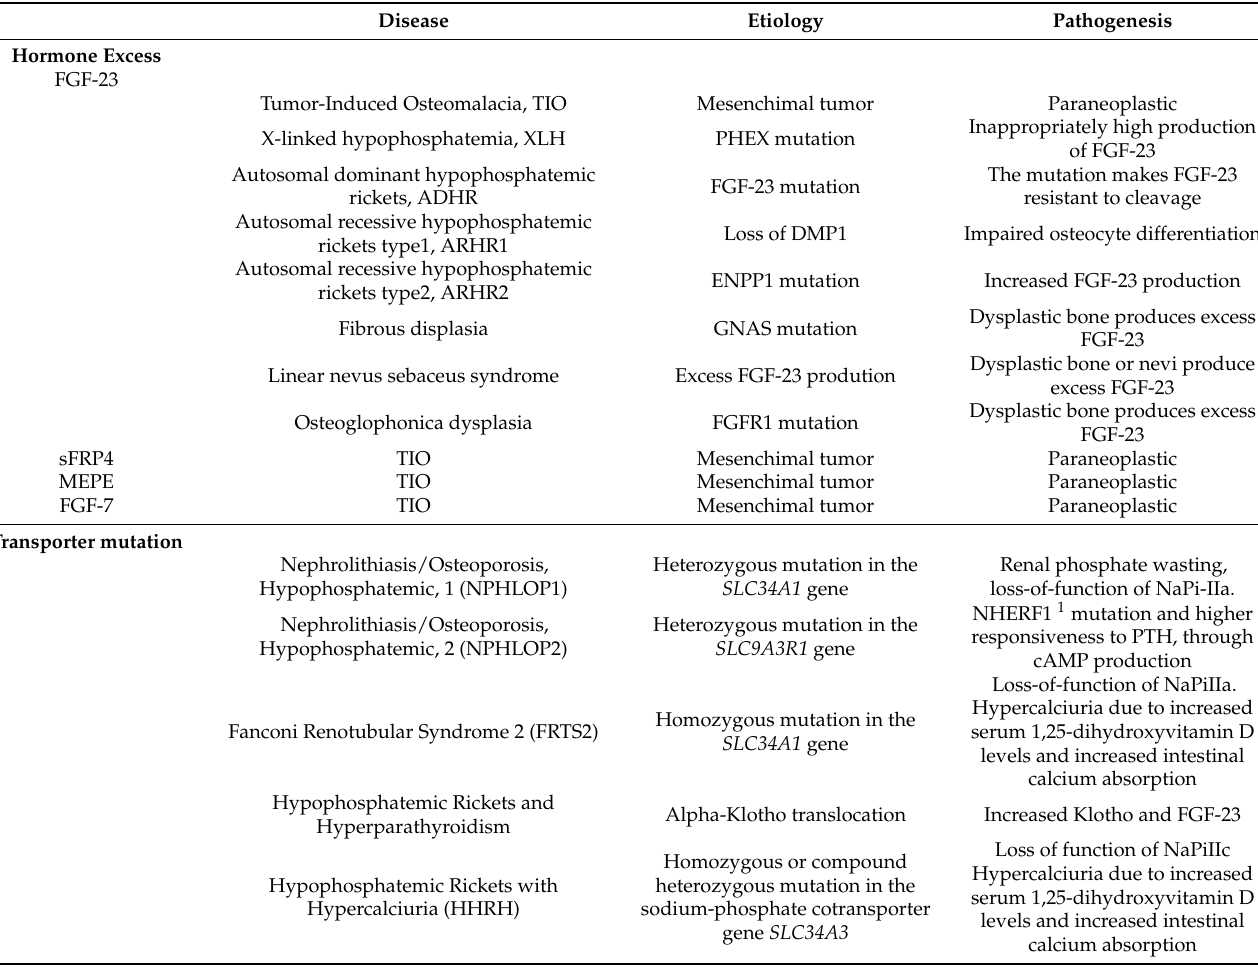
Table 1. Hypophosphatemia due to renal phosphate loss other than primary